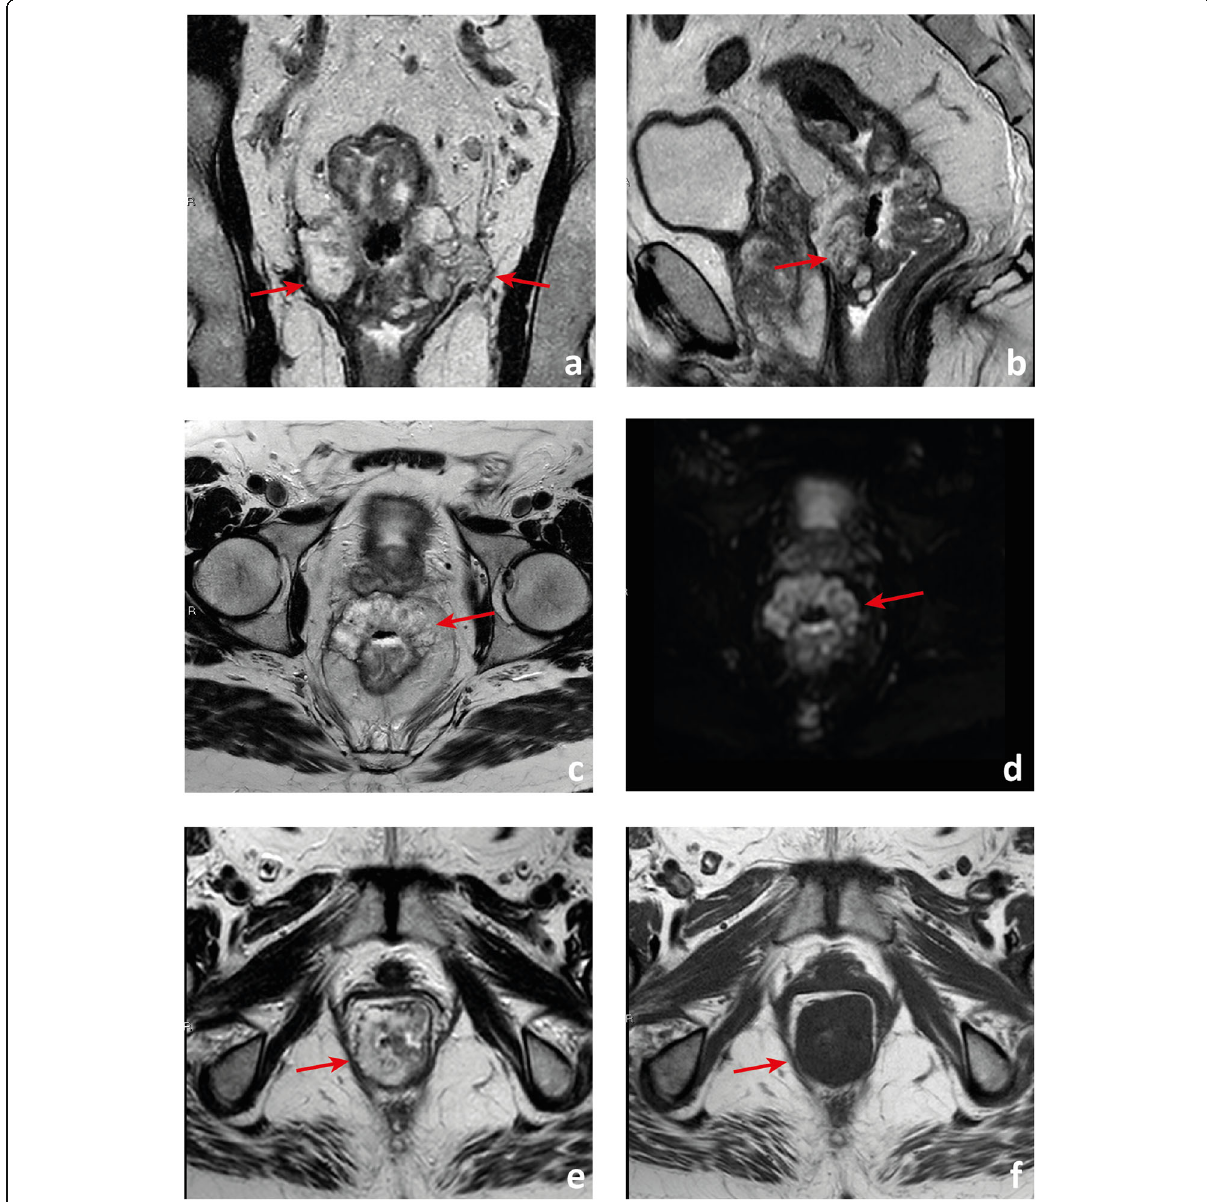
Fig. 21 In a to c , we observe a low/mid rectal cancer with a predominance of high signal intensity in accordance with a mucinous histologic subtype. It presents with bilateral (arrows in a ) and anterior (arrow in b ) transgression of the mesorectal fascia, extending into the pelvic sidewall and middle pelvic compartment, respectively. It may not be easy to define its exact boundaries due to the approximation of signal intensity to that of fat (arrow in c ). b0 DWI images are fat-suppressed T2-WI and may aid in the distinction (arrow in d ). T1WI may work even better, namely to define or exclude a fat plane between tumour and circumferential margin of resection. In e , a low mucinous rectal cancer appears to invade the levator muscle on T2-WI but in the corresponding T1WI ( f ), we see a thin fat plane between the